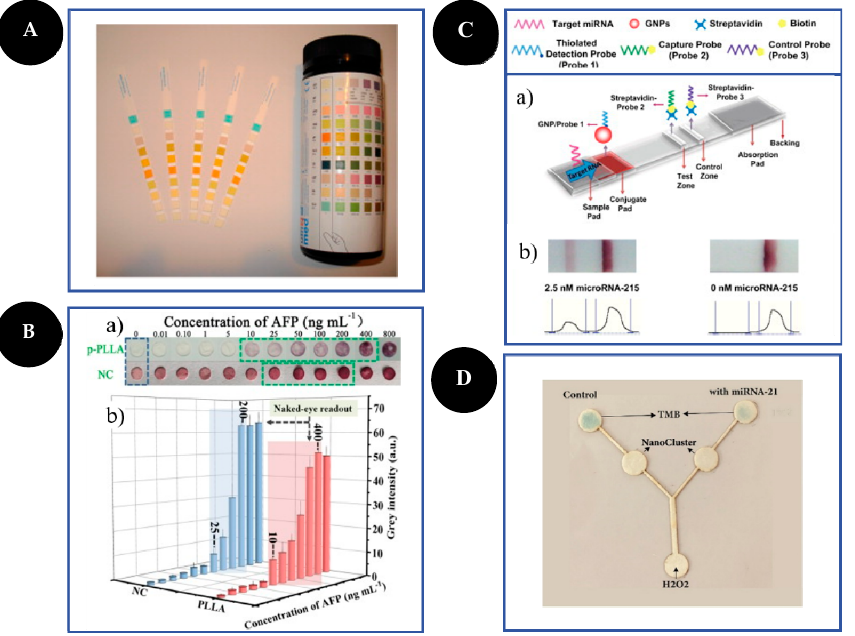
Figure 2. Examples of different types of PADs. Dipsticks ( A ): urine test strips. Reproduced and adapted with permission from [13]; Spot test ( B ): photographs ( a ) and bar charts ( b ) of the corre- sponding grey values of the colorimetric readout based on a highly porous poly(L-lactic) acid nanofiber and NC platforms for AFP detection. Reproduced and adapted with permission from [30]; LFA ( C ): schematic representation of LFA principle for the detection of microRNA-215 ( a ) and photographs and corresponding optical measurements ( b ) of the developed LFA in the presence (2.5 nM) and absence (0 nM) of microRNA-215. Reproduced and adapted with permission from [32]; μ PAD ( D ): photograph of the microfluidic sensor for detection of 1000 pM of microRNA-21 based on peroxidase mimetic activity of DNA-templated Ag/Pt nanoclusters. Reproduced and adapted with permission from [26].